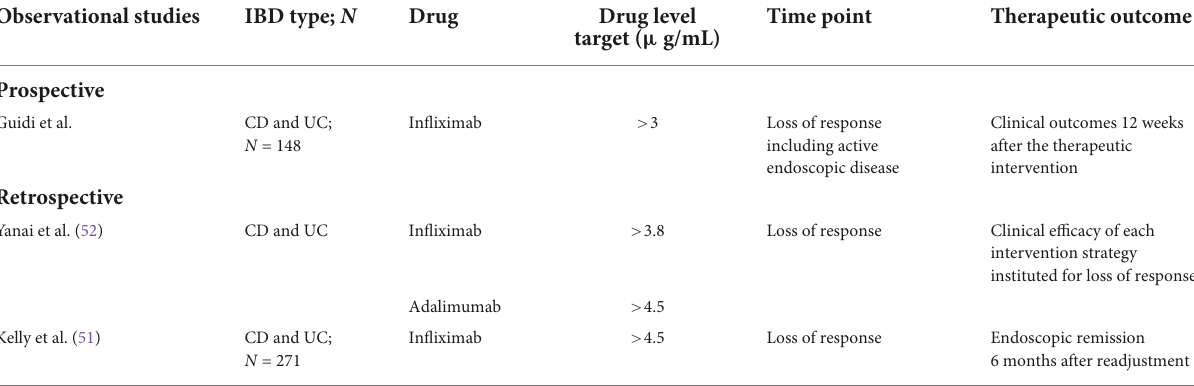
TABLE 5 Summary of most relevant reactive TDM